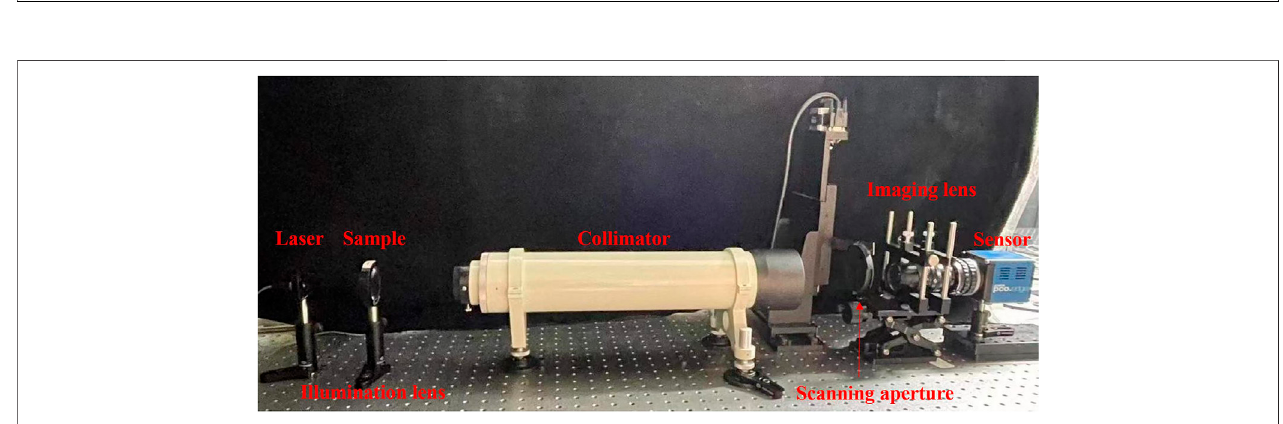
FIGURE 4 | The phase diversity-based Fourier ptychography (PDFP) experimental setup.